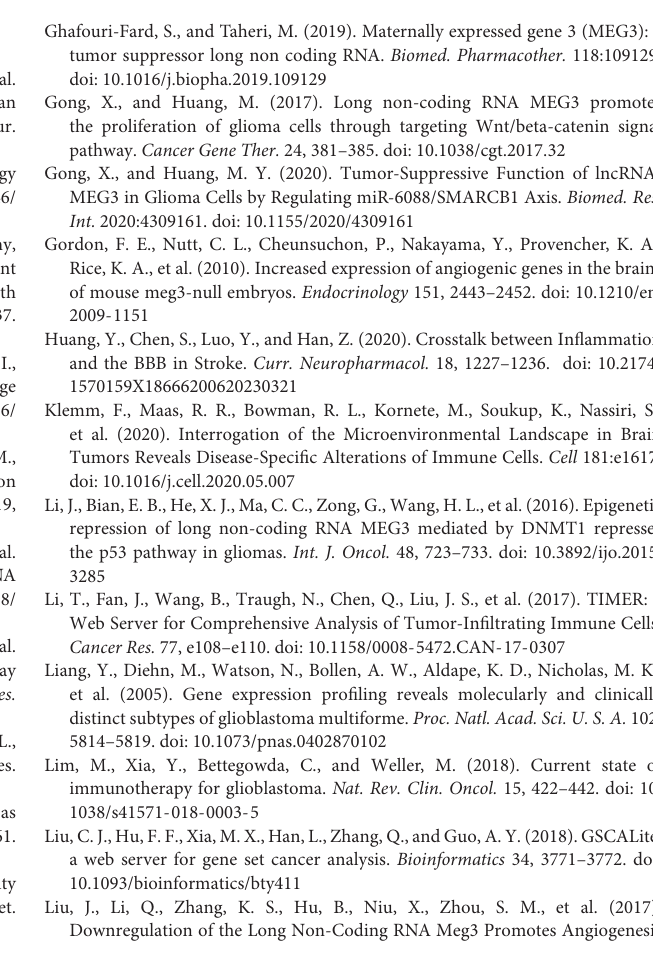
Supplementary Figure 1 | MEG3 expression levels in GBM and LGG in the GEPIA database. Supplementary Figure 2 | Kaplan-Meier survival curves comparing the low and high expression of MEG3 in LGG and GBM using the GEPIA